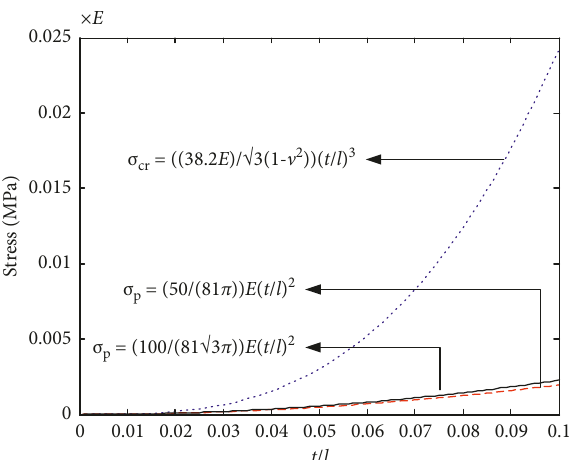
Figure 6: Three calculation models for the peak stress of metal